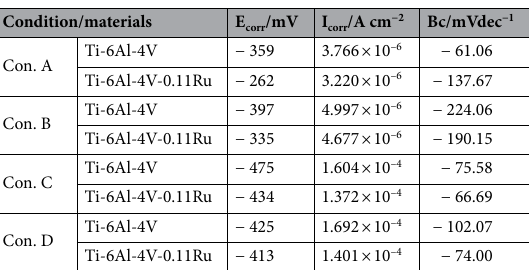
Table 1. Electrochemical parameters of different titanium alloys under various test conditions.